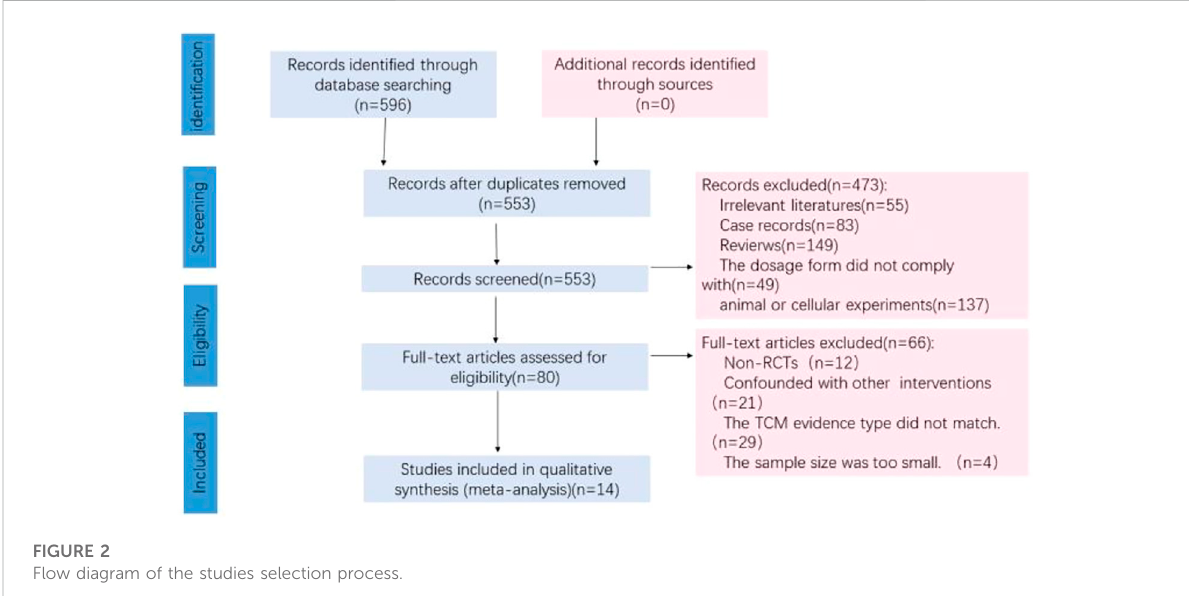
FIGURE 2 Flow diagram of the studies selection process.